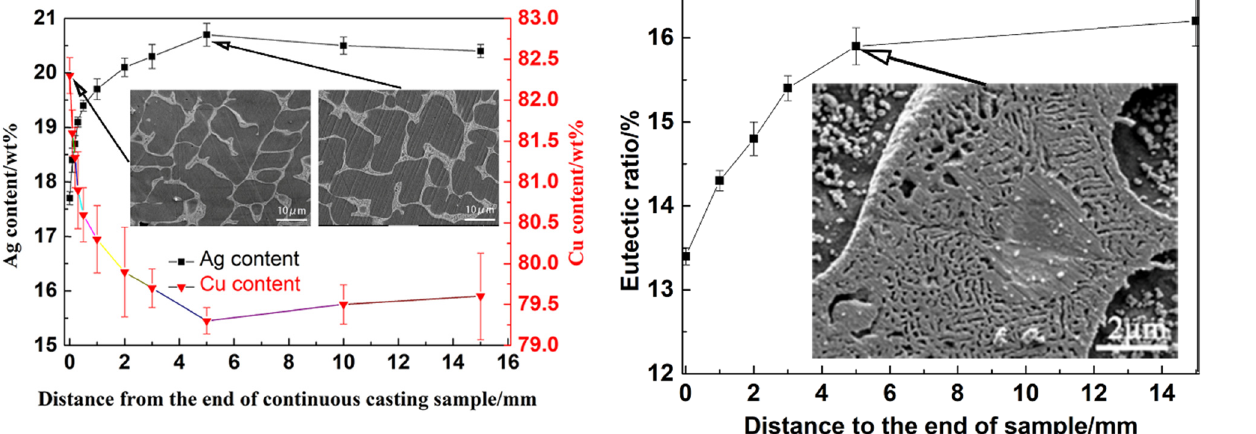
Figure 5: Variation curve of end eutectic volume of Cu – 20% Ag alloy in vertically cooled continuous